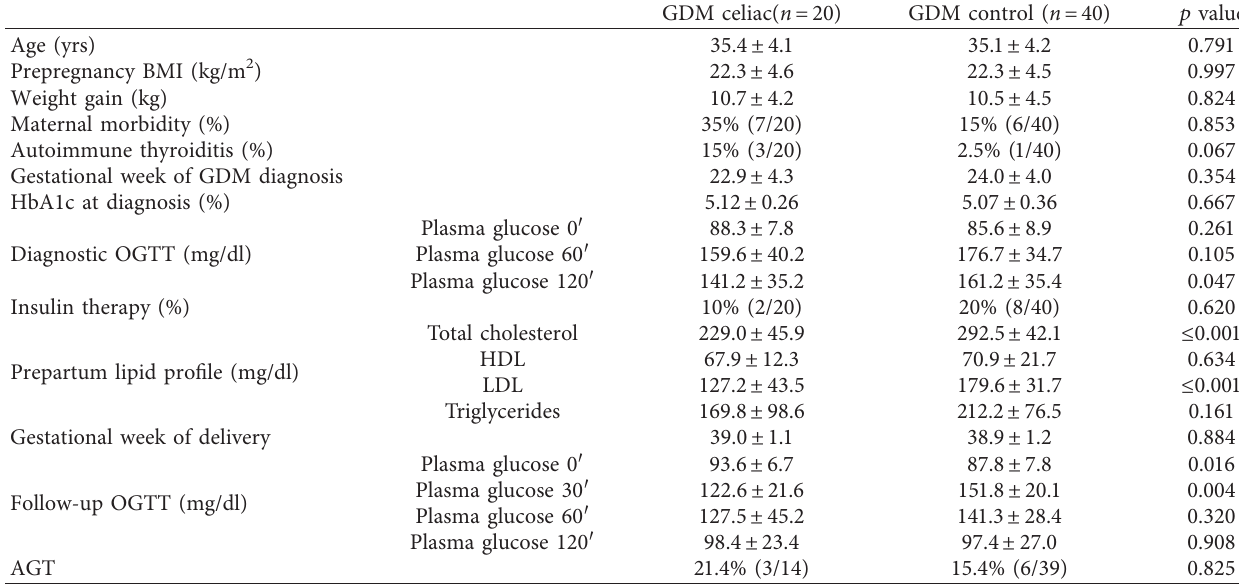
Table 1: Clinical and metabolic characteristics of 20 women with GDM and CD and 40 women with GDM without CD (data are means ± standard